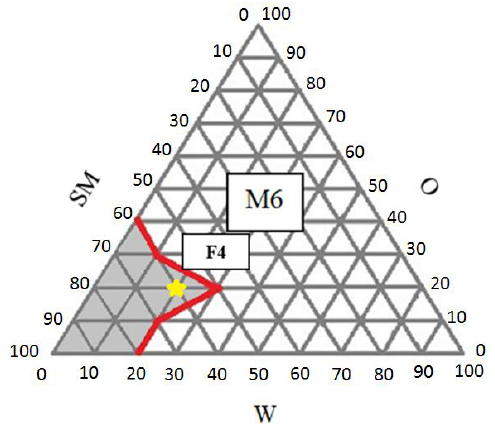
Figure 3. Plot of F4 on pseudo-ternary phase diagram M6 (W = water, O = oil, and SM = surfactant mixture).